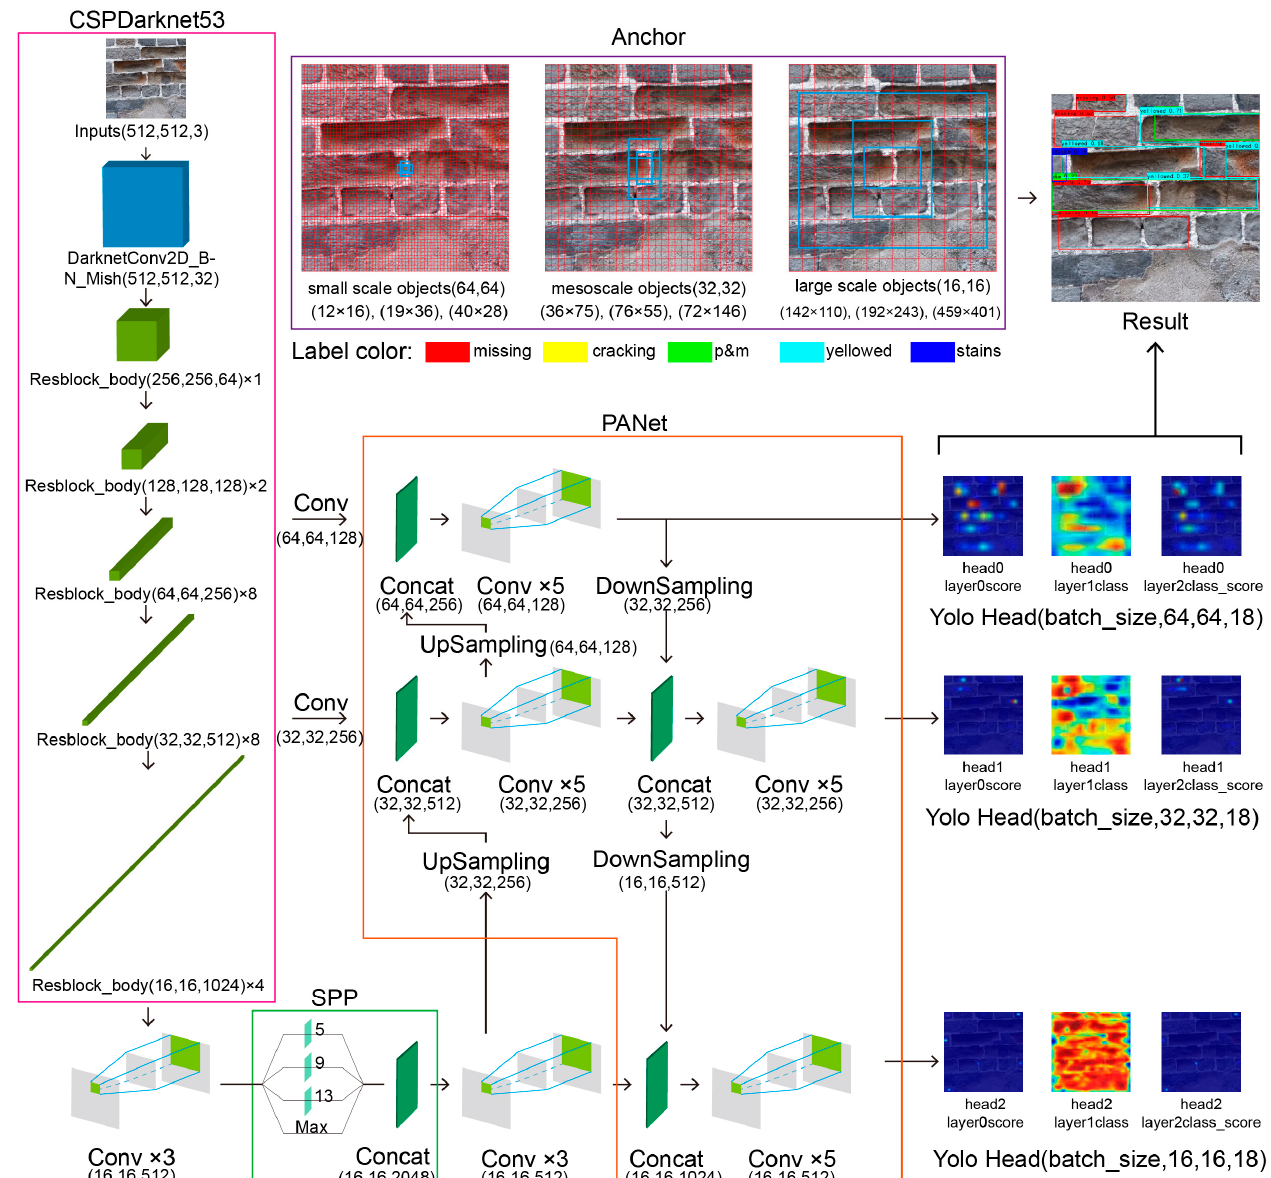
Figure 7. YOLOv4 network framework. (Image Source: drawn by the author).